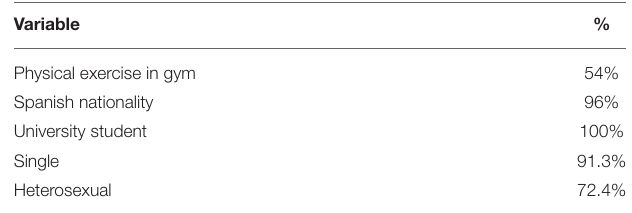
TABLE 1 | Sociodemographic data of the